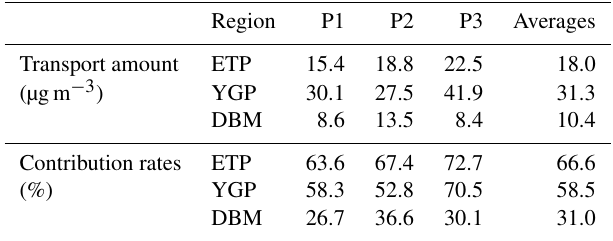
Table 5. Amounts and contribution rates of PM 2 . 5 trans-boundary transport from the SCB to surface PM 2 . 5 concentrations averaged over the eastern TP edge (ETP), northern YGP edge (YGP), and DBM region during the formation (P1), maintenance (P2), and dissipation (P3) periods of the heavy haze pollution event over the SCB